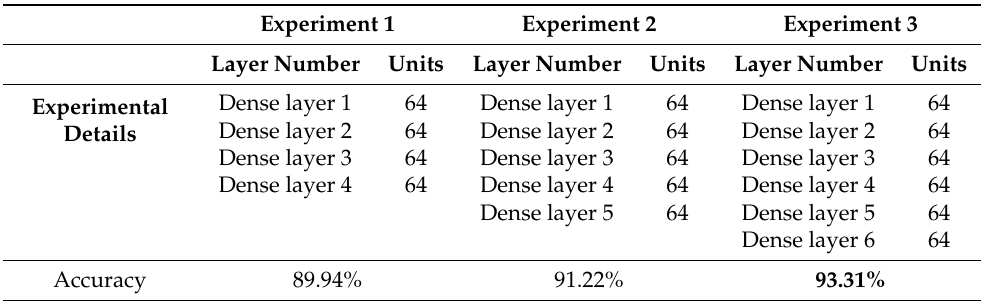
Table 6. Accuracy (in %) comparison of proposed models with different numbers of deep-neural- network